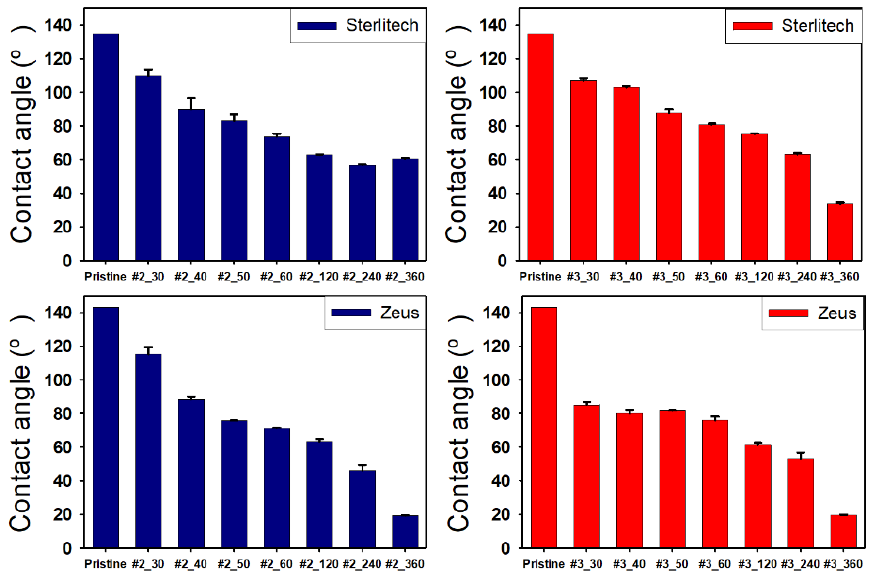
Figure 5. Change of contact angle of the surface of the porous PTFE substrate treated by GA and TMPEDA (#2) at the left-hand side ( blue ) and GA and TMPDETA (#3) at the right-hand side ( red ) with incubation time and the type of substrates (Sterlitech in the top row and Zeus in the bottom row).